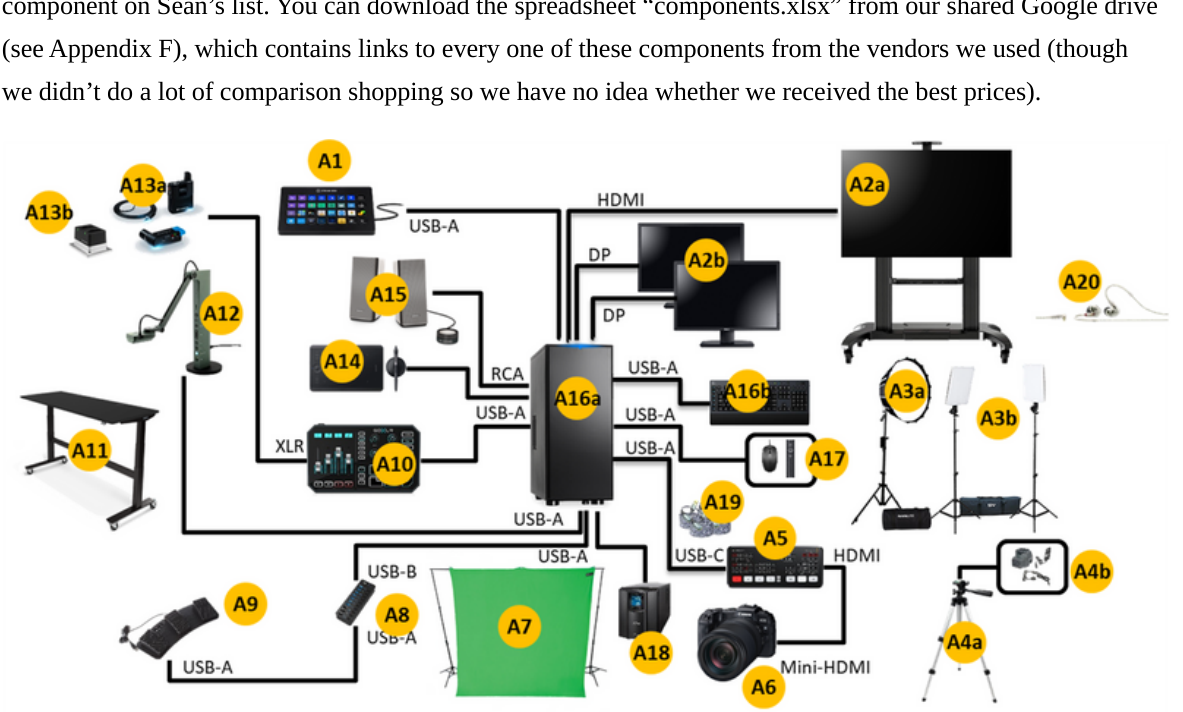
Figure A1. Wiring diagram for Andrew’s studio (component labels correspond to those in the equipment list in Figure